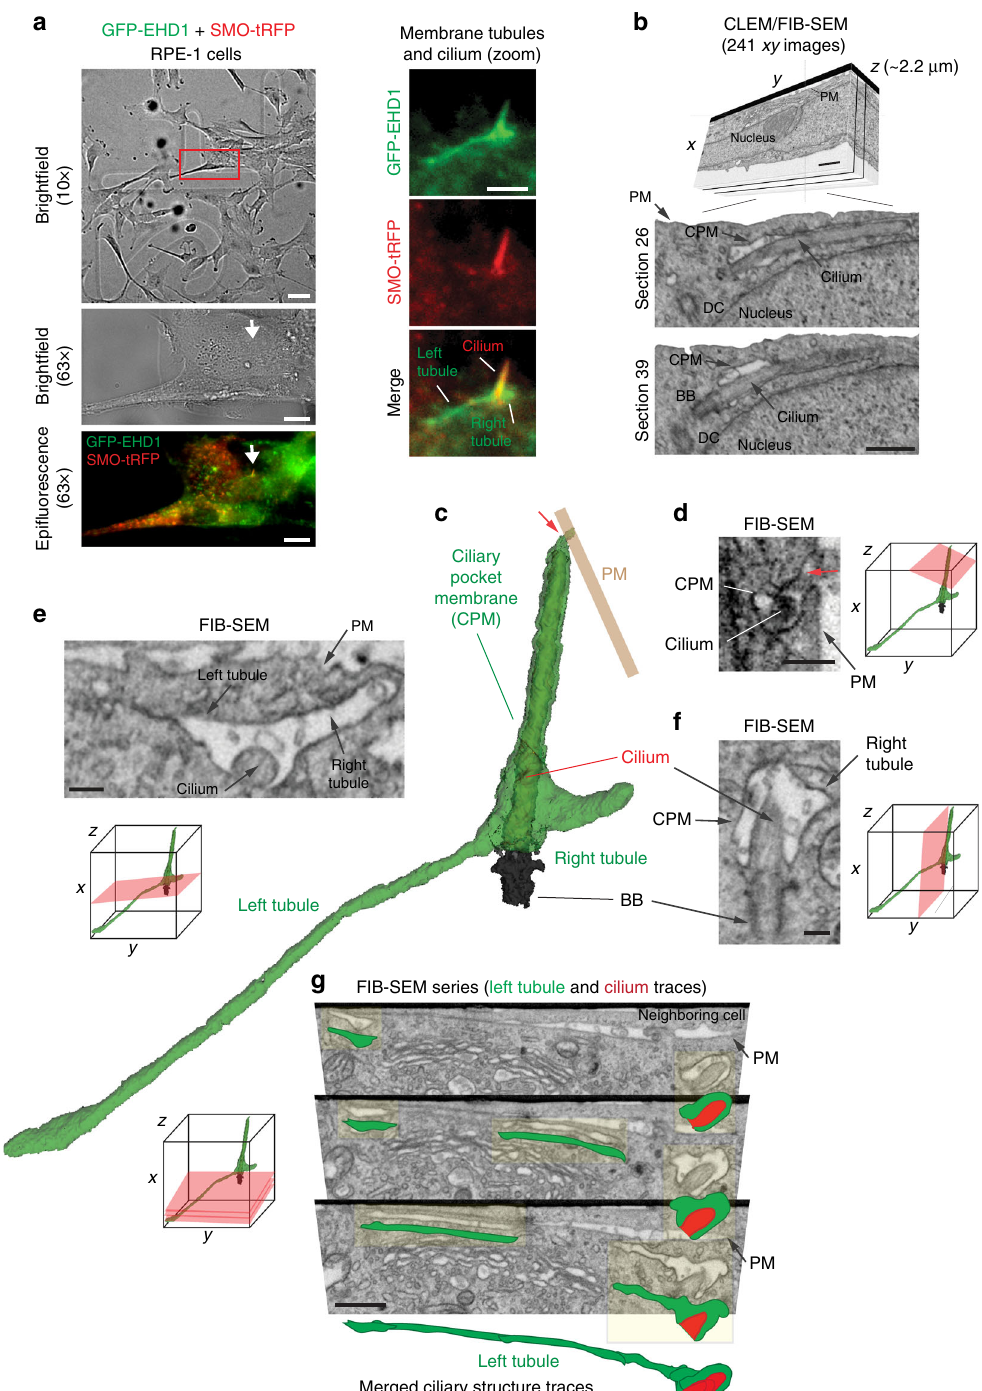
reduced the frequency of these structures (Fig. 8h, Supplementary Figure 7e). Together, our fi ndings indicate that membrane tubules originate from the CV/ciliary sheath membrane and require microtubules to grow towards the cell surface, where these membrane structures fuse to form the EMC (Fig. 8i). ciated with ciliogenesis in vivo in zebra fi sh. We examined the